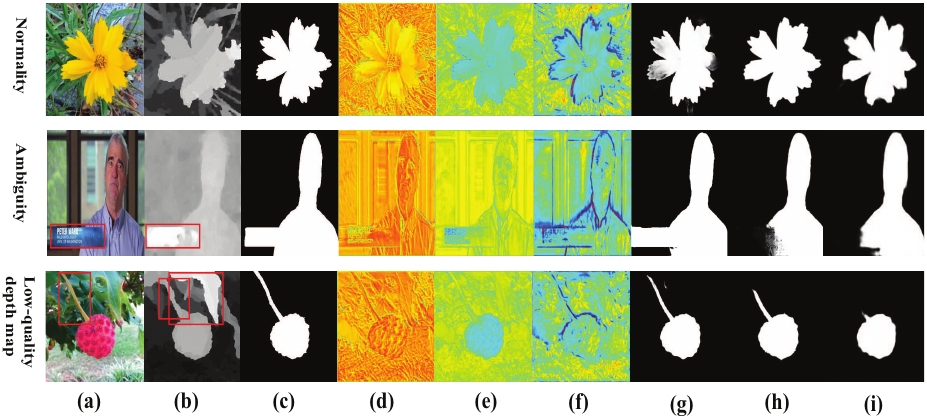
Figure 4. Visual demonstrations of cross-modal fusion in CAFM. The annotations are ( a ) RGB images, ( b ) depth maps, ( c ) ground truth, ( d ) RGB feature in 1st level of RGB Encoder, ( e ) depth features in 1st level of depth Encoder, ( f ) the fused features of ( d ) and ( e ) by CAFM, ( g ) the predicted saliency map, ( h ) the predicted saliency map by ASIFNet [35], and ( i ) the predicted saliency map by CoNet [36]. The red boxes indicate the ambiguity of cross-modal